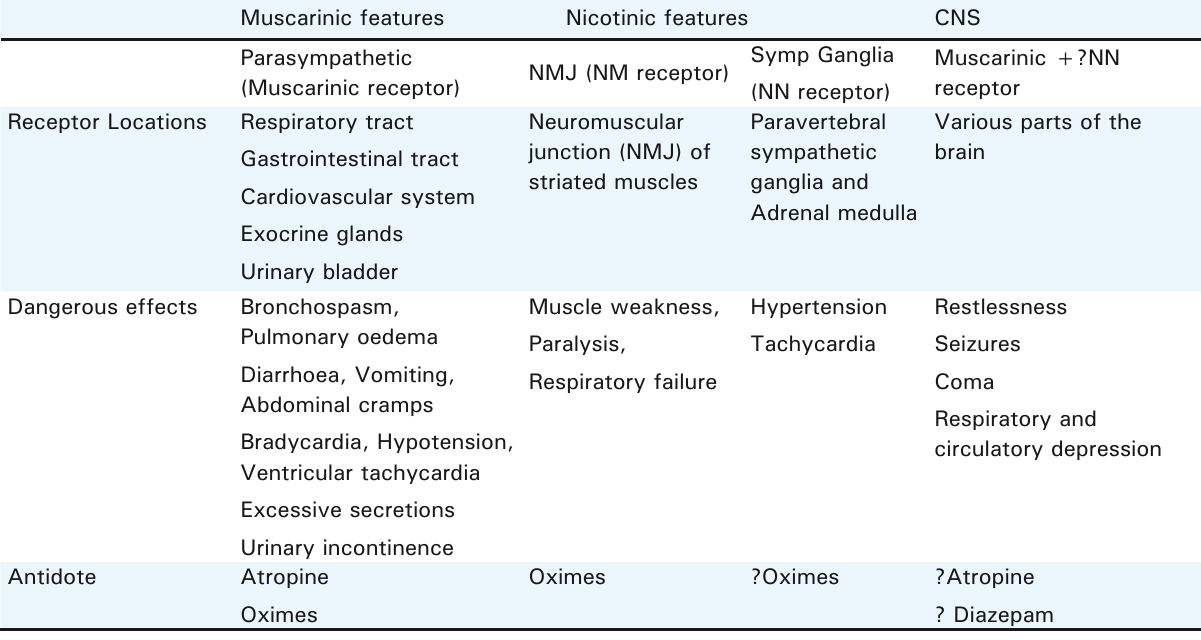
table 3. Summary of clinical features and antidotes in Acute Cholinergic